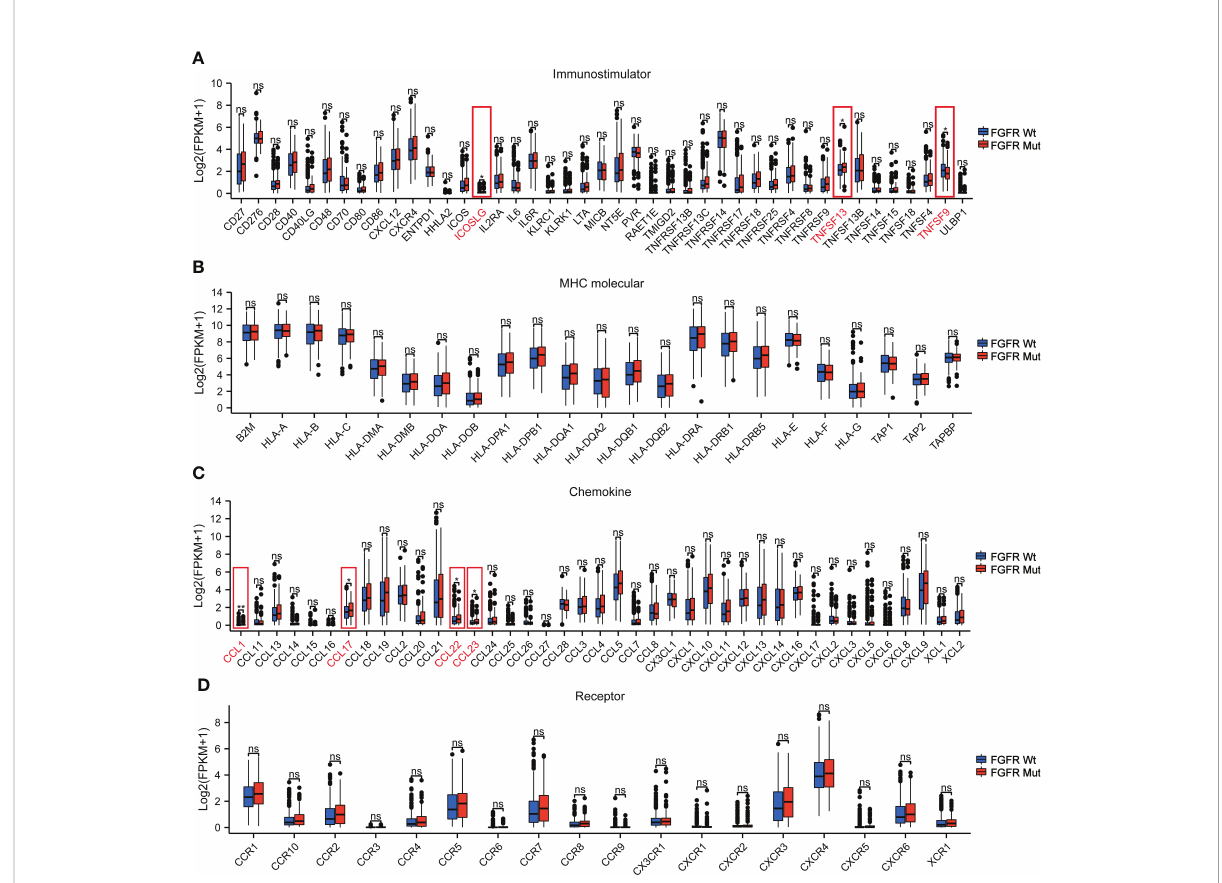
FIGURE 8 The association of FGFR Mut with anti-tumor immunity signatures in melanoma. (A) The expression levels of immuno-stimulator related genes in FGFR Mut versus FGFR Wt melanoma. (B) The expression levels of MHC molecule related genes in FGFR Mut versus FGFR Wt melanoma. (C, D) Comparison of chemokines and their receptors between FGFR Mut and FGFR Wt melanoma (ns = not signi fi cant, *P < 0.05, **P <